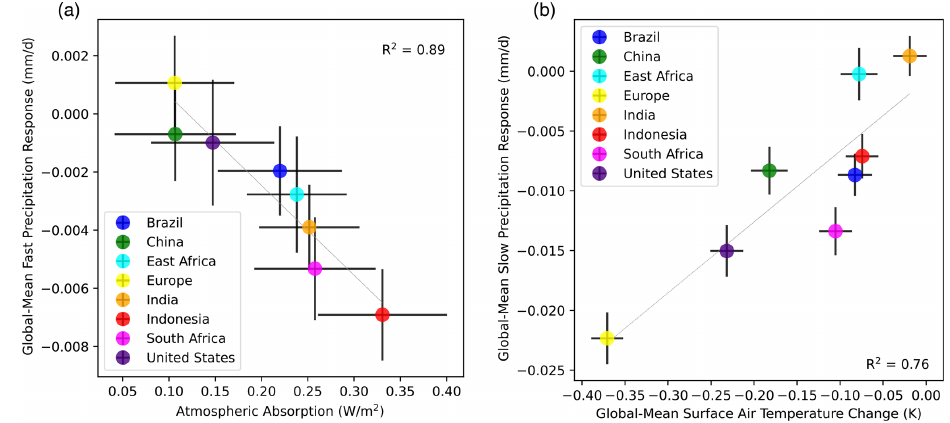
Figure 2. The total global-mean precipitation response to emissions from each region can be decomposed in the (a) global-mean fast precipitation response (mmd − 1 , y axis), which is strongly correlated with the global-mean change in atmospheric absorption (Wm − 2 , x axis), and the (b) global-mean slow precipitation response (mmd − 1 , y axis), which is strongly correlated with the global-mean change in surface temperature (K, x axis). Error bars provide the 95% confidence interval ( ± 1 . 96 σ ).